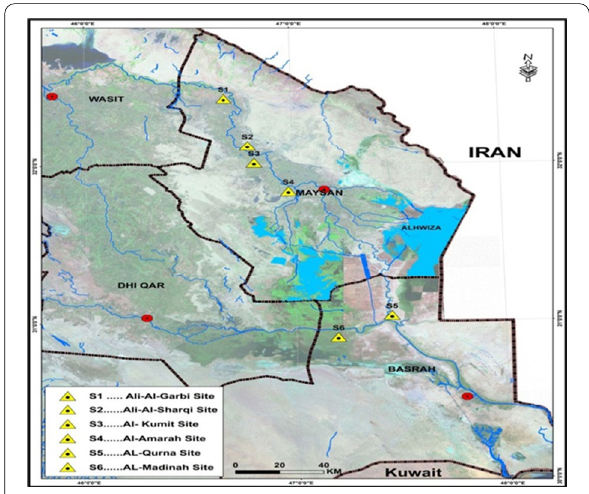
Fig. 1 Map of sites for sampling the roots of wheat and soil in Basra and Maysan